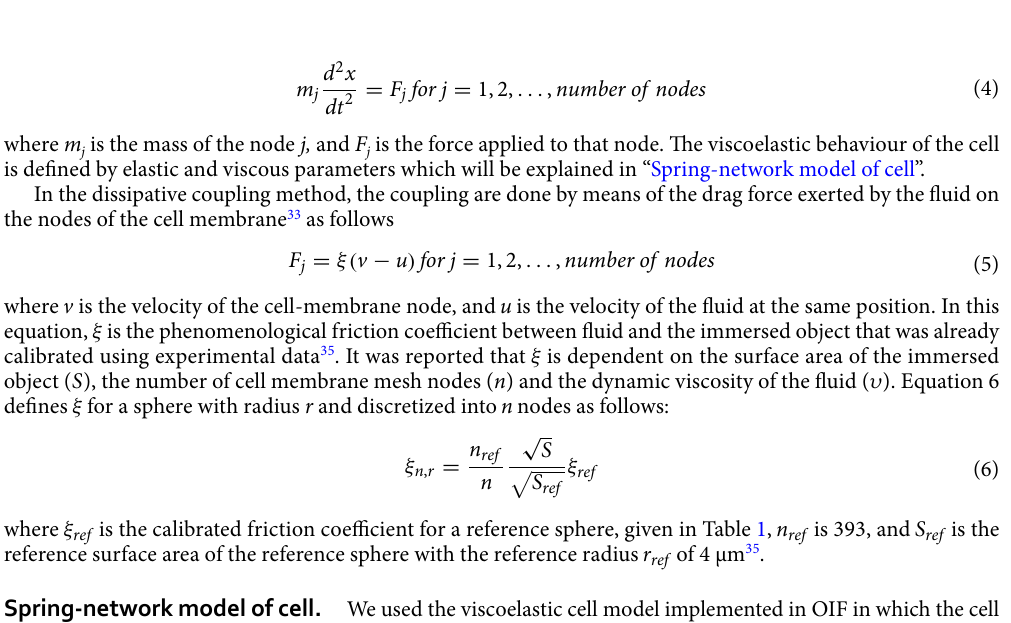
Table 1. ξ ref for the reference sphere ( r = 4 µm, n = 393) immersed in three different fluids 35